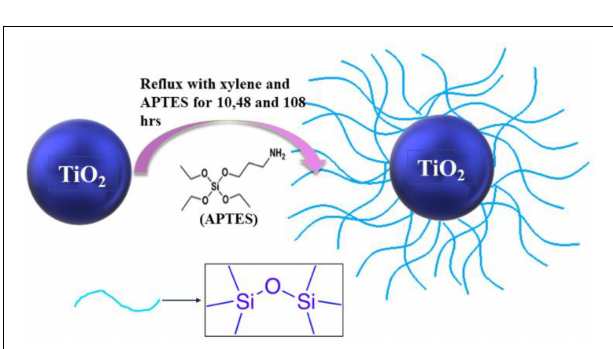
FIGURE 2 | Schematic of treatment of TiO 2 NPs with APTES.